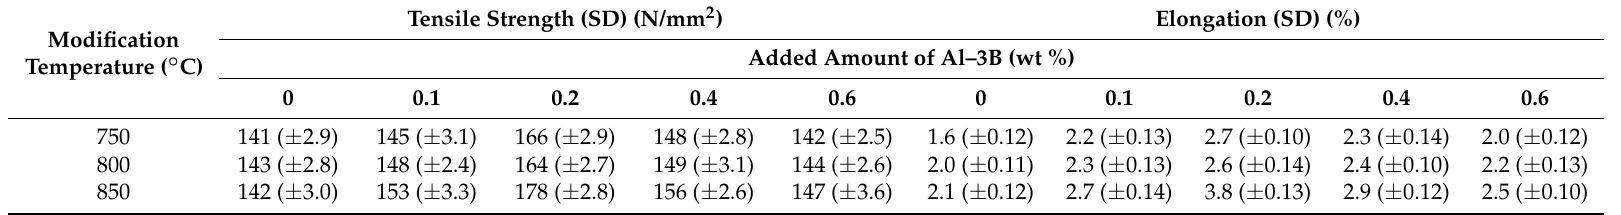
Table 3. Mechanical properties of Al–18Si before and after